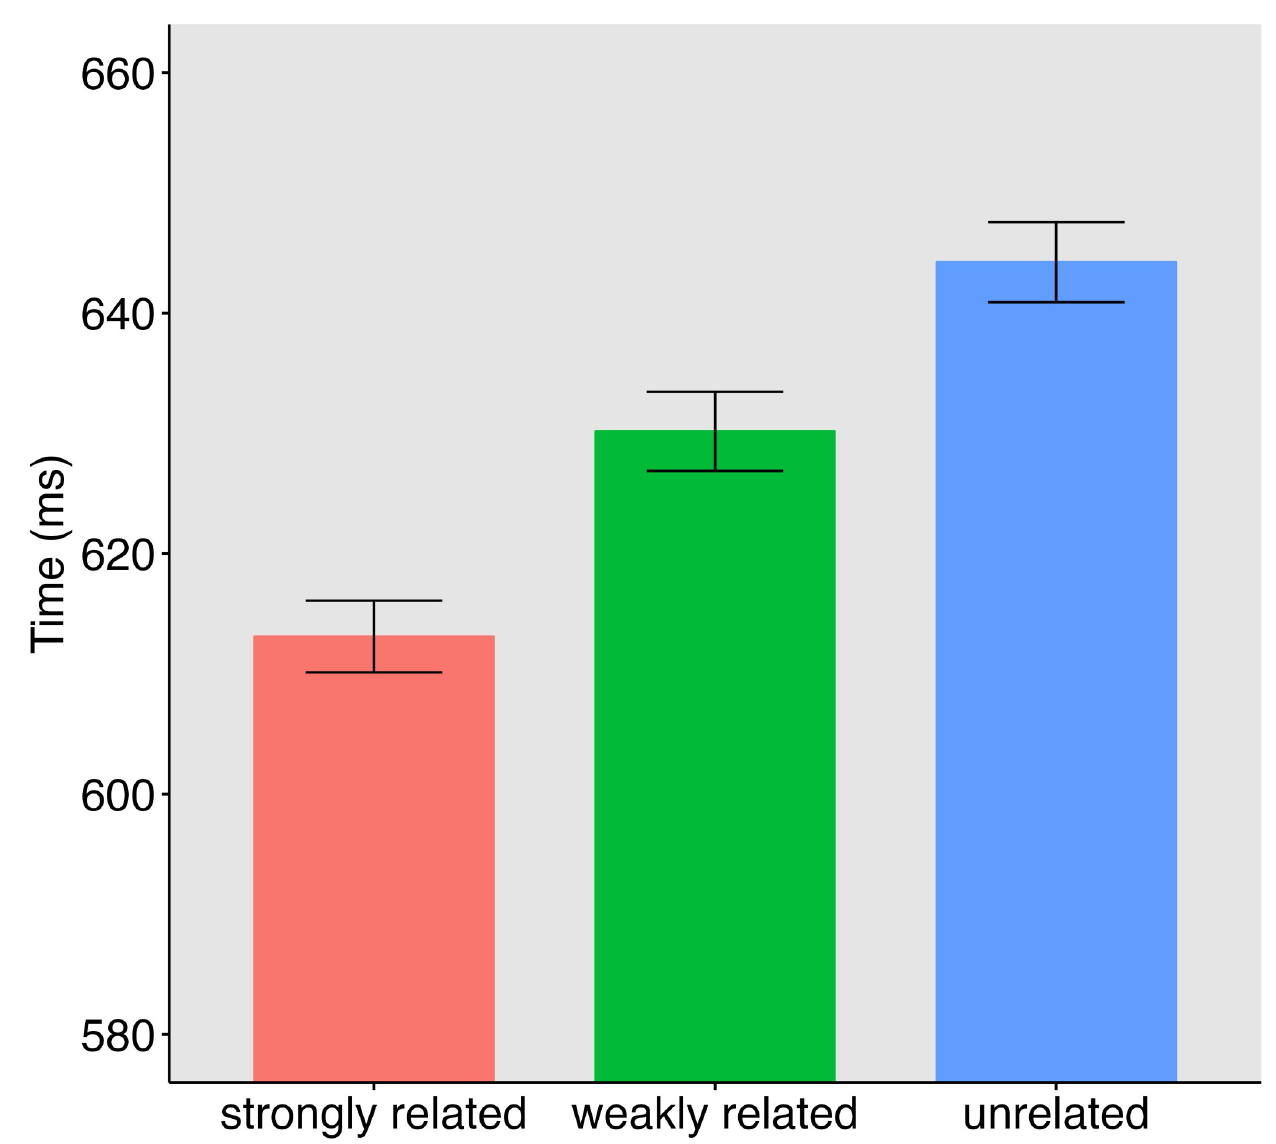
Fig 2. Mean reaction times and standard errors for the three priming conditions in Experiment